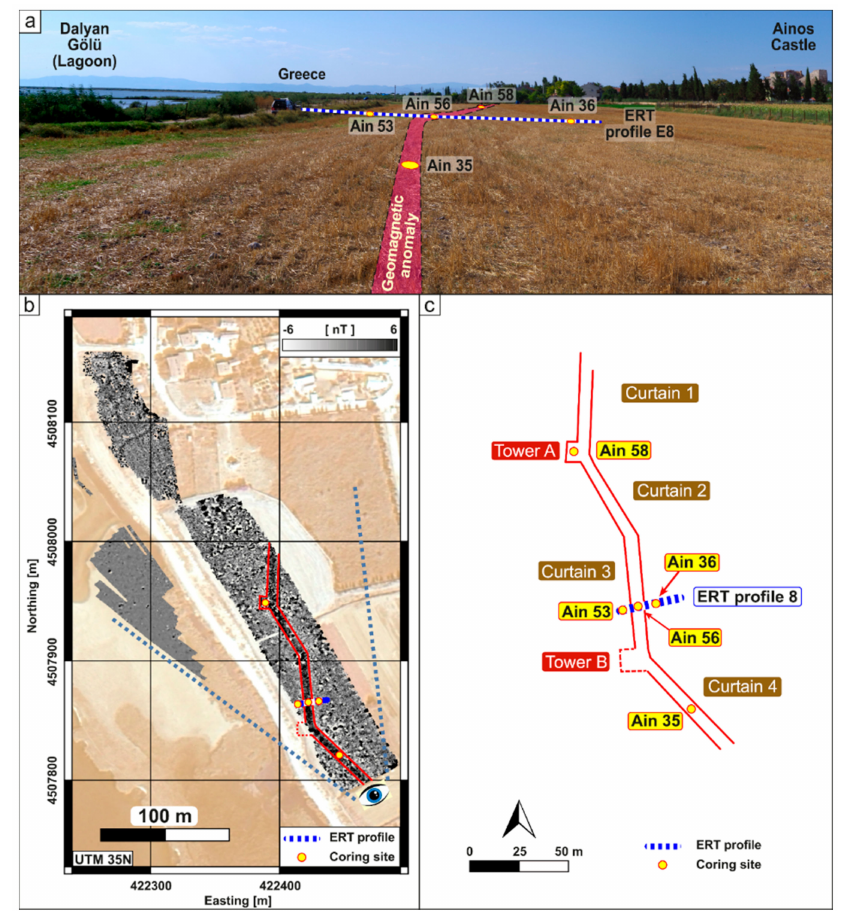
Figure 3. The area of interest (for location see Figure 2). ( a ) Panoramic view of the research area facing northwest (taken on 01 September 2015 by M.S.; the eye in Figure 3b represents the camera position). It shows the prospected wall course, corings Ain 35, 36, 53, 56, and 58, and ERT (Earth Resistivity Tomography) profile 8; ( b ) Results of the MG (Magnetic Gradiometer) survey added by the locations of the corings (left); ( c ) Schematic overview presenting the prospected wall course, as well as the locations of the corings and ERT profile E8